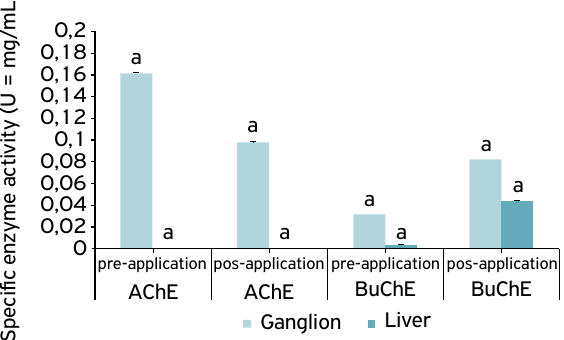
6. Evaluation of enzymatic activity of the acetylcholinesterase (AChE) and butyrylcholinesterase (BuChE) in tissues (liver and ganglia) of Achatina fulica depending on the concentration of protein extract of tissue proteins, before and after application of the alcoholic extract of Capsicum frutescens to 10% (Tukey, p